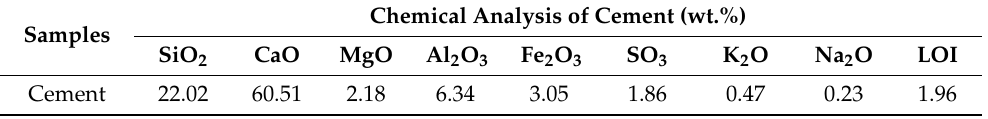
Table 1. Chemical analysis of cement (wt.%).